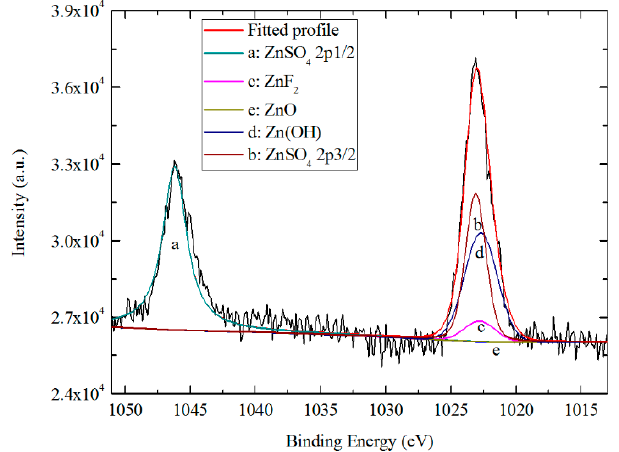
Figure 16. High resolution XPS spectrum and curve fitting for Zn 2 p photoelectron region for a TCC formed on Zn55Al for 180 s in TCP bath at 40 ° C.